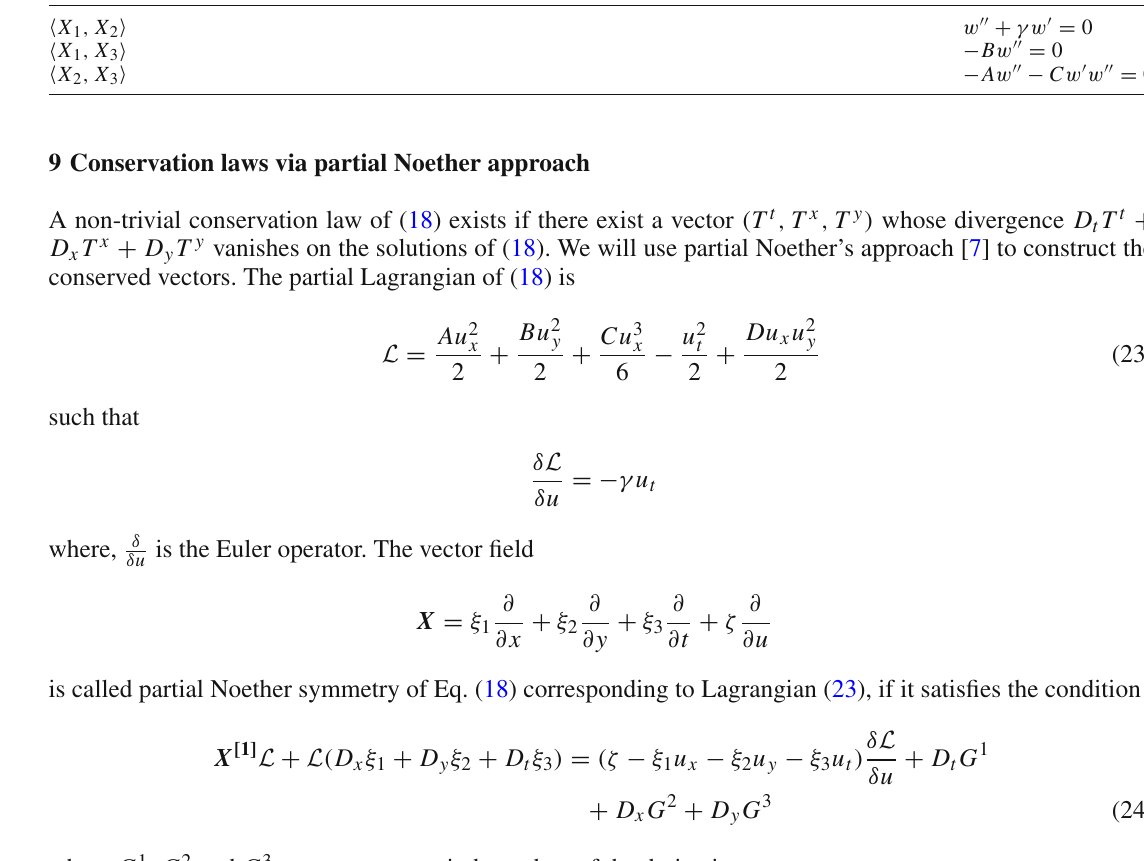
Table 4 Reductions of Eq. (18) Algebra